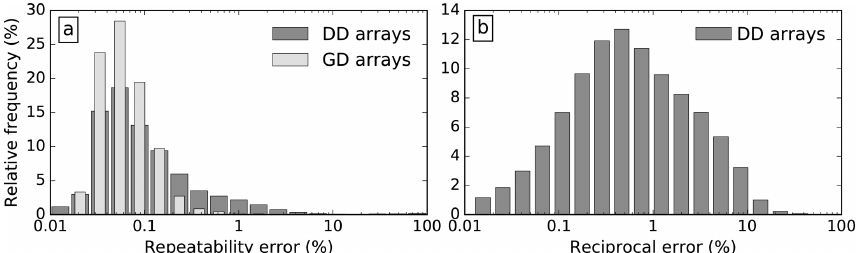
Figure 3. Relative frequency of (a) the repeatability (stacking) error for the whole GD and DD data sets, and (b) the reciprocal error for the whole DD data set.